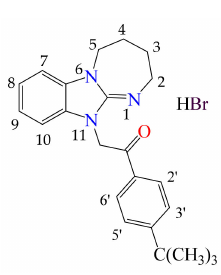
Figure 11. Compound 2c .